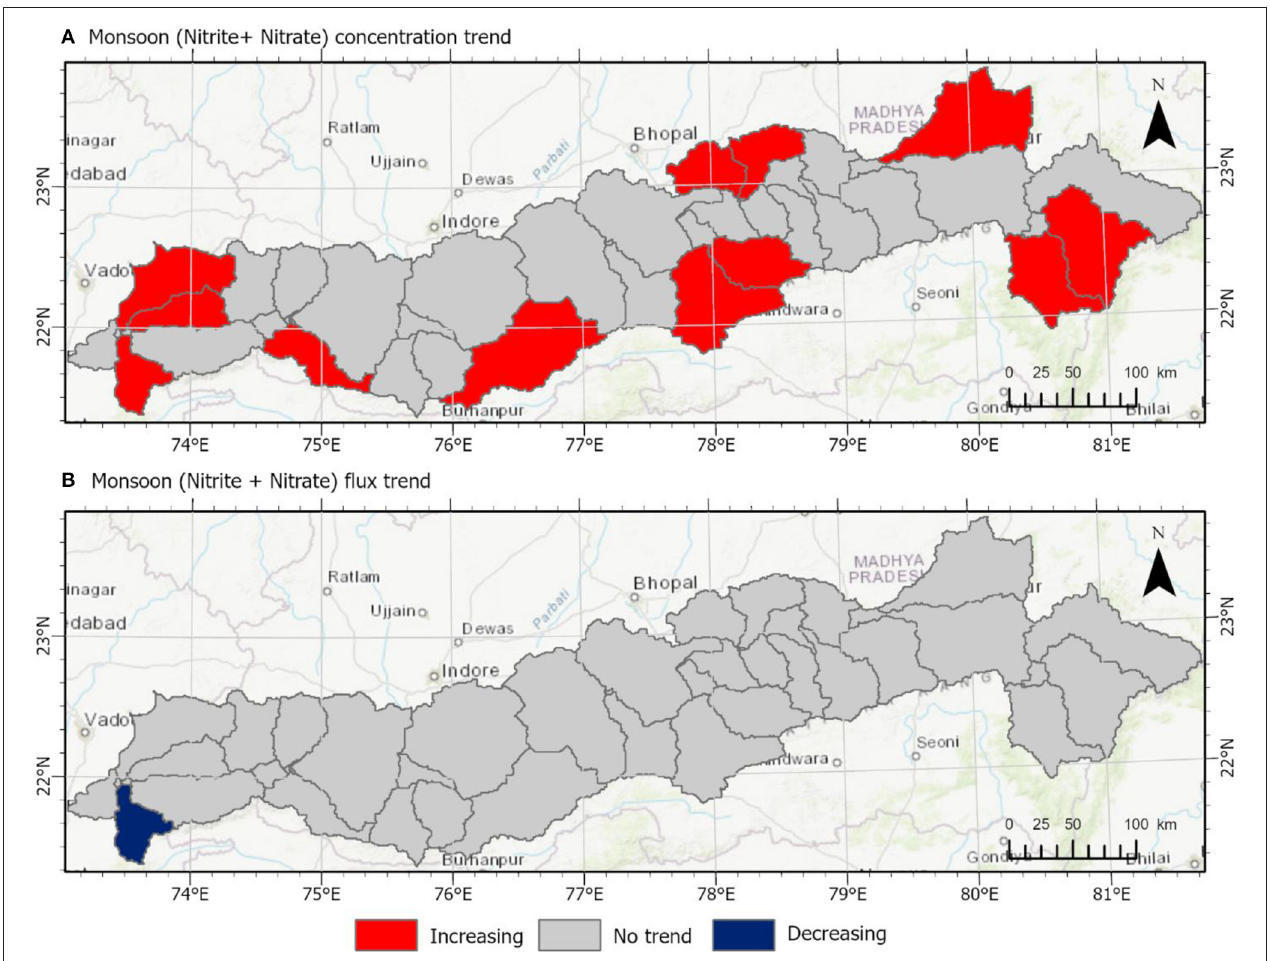
FIGURE 9 | (A,B) : (A) Monsoonal (NO 2 + NO 3 ) concentration trend spatial variation across the Narmada River basin. (B) Monsoonal (NO 2 + NO 3 ) flux trend spatial variation across the Narmada River basin. Mann-Kendall trend test was used to estimate the monotonic trends for each subbasin. All trends are significant at p <